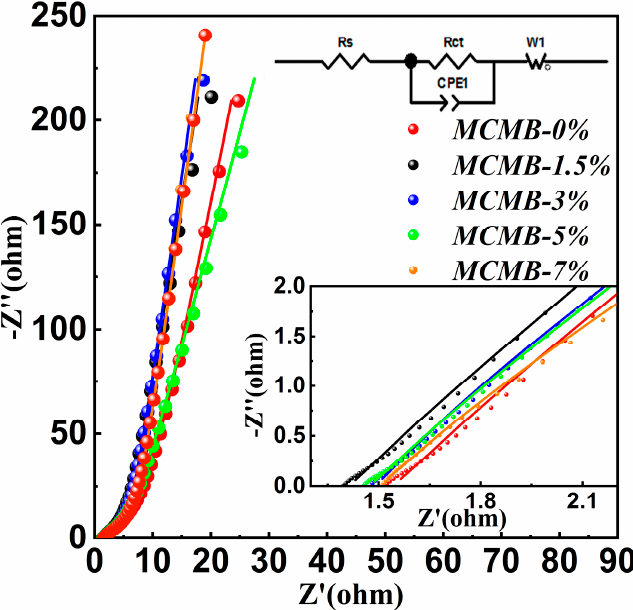
Figure 8. Alternating current impedance spectrum of MCMBs.